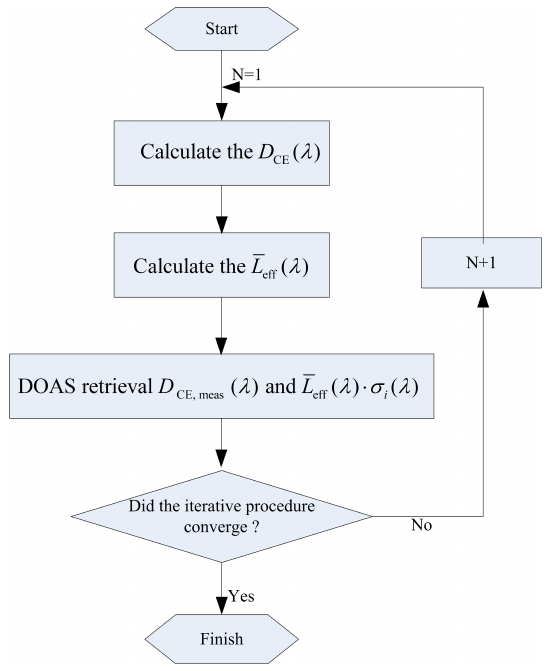
Figure 4. Flow chart of an iterative retrieval scheme for IBBCEAS.